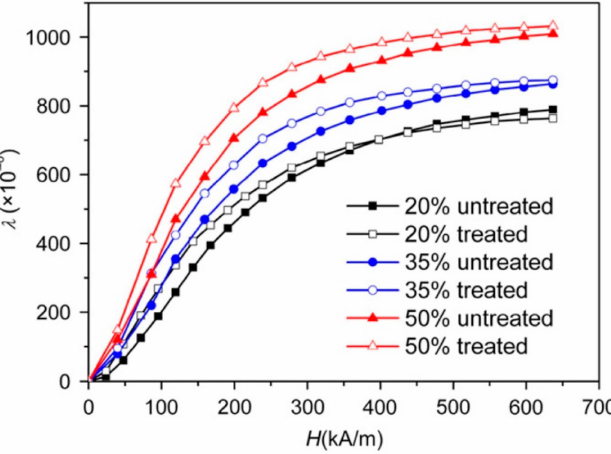
Figure 17. Comparison of the relationship between magnetostriction and magnetic field strength of composites with different particle volume fractions when the particles are treated with coupling agent or